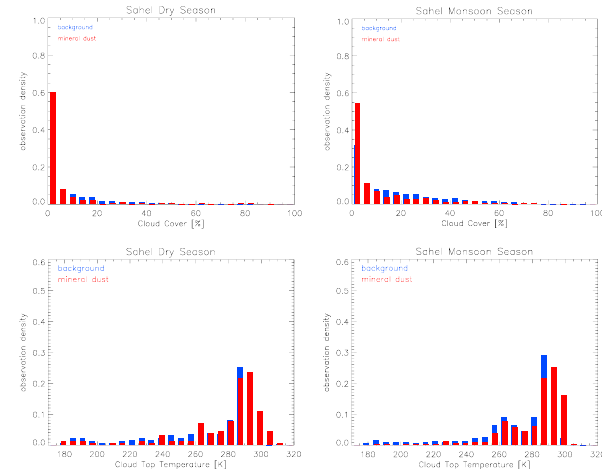
Fig. 5. Observation density differences of MODIS liquid cloud ef- fective radius for moderate (left) and heavy dust (right) classes and different flow regimes (air masses) during the wet (blue) and dry (red) season.